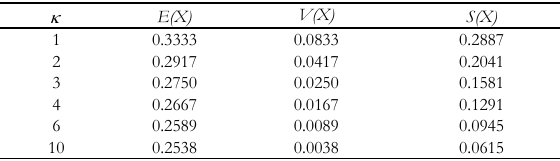
Expected value and variance of a symmetric STSP for some values of κ κ